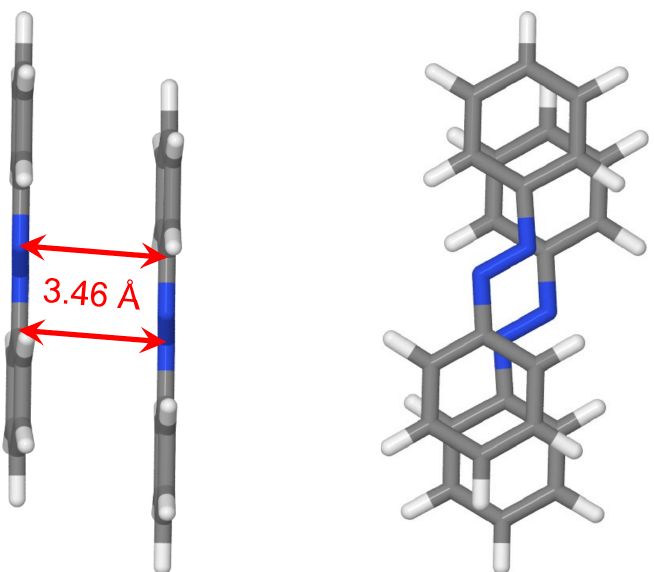
Figure 12. Two views of the optimized dimer geometry. The shortest intermolecular CN distances are shown. The geometry was optimized at the B3LYP+D3(BJ)/def2-TZVP level of